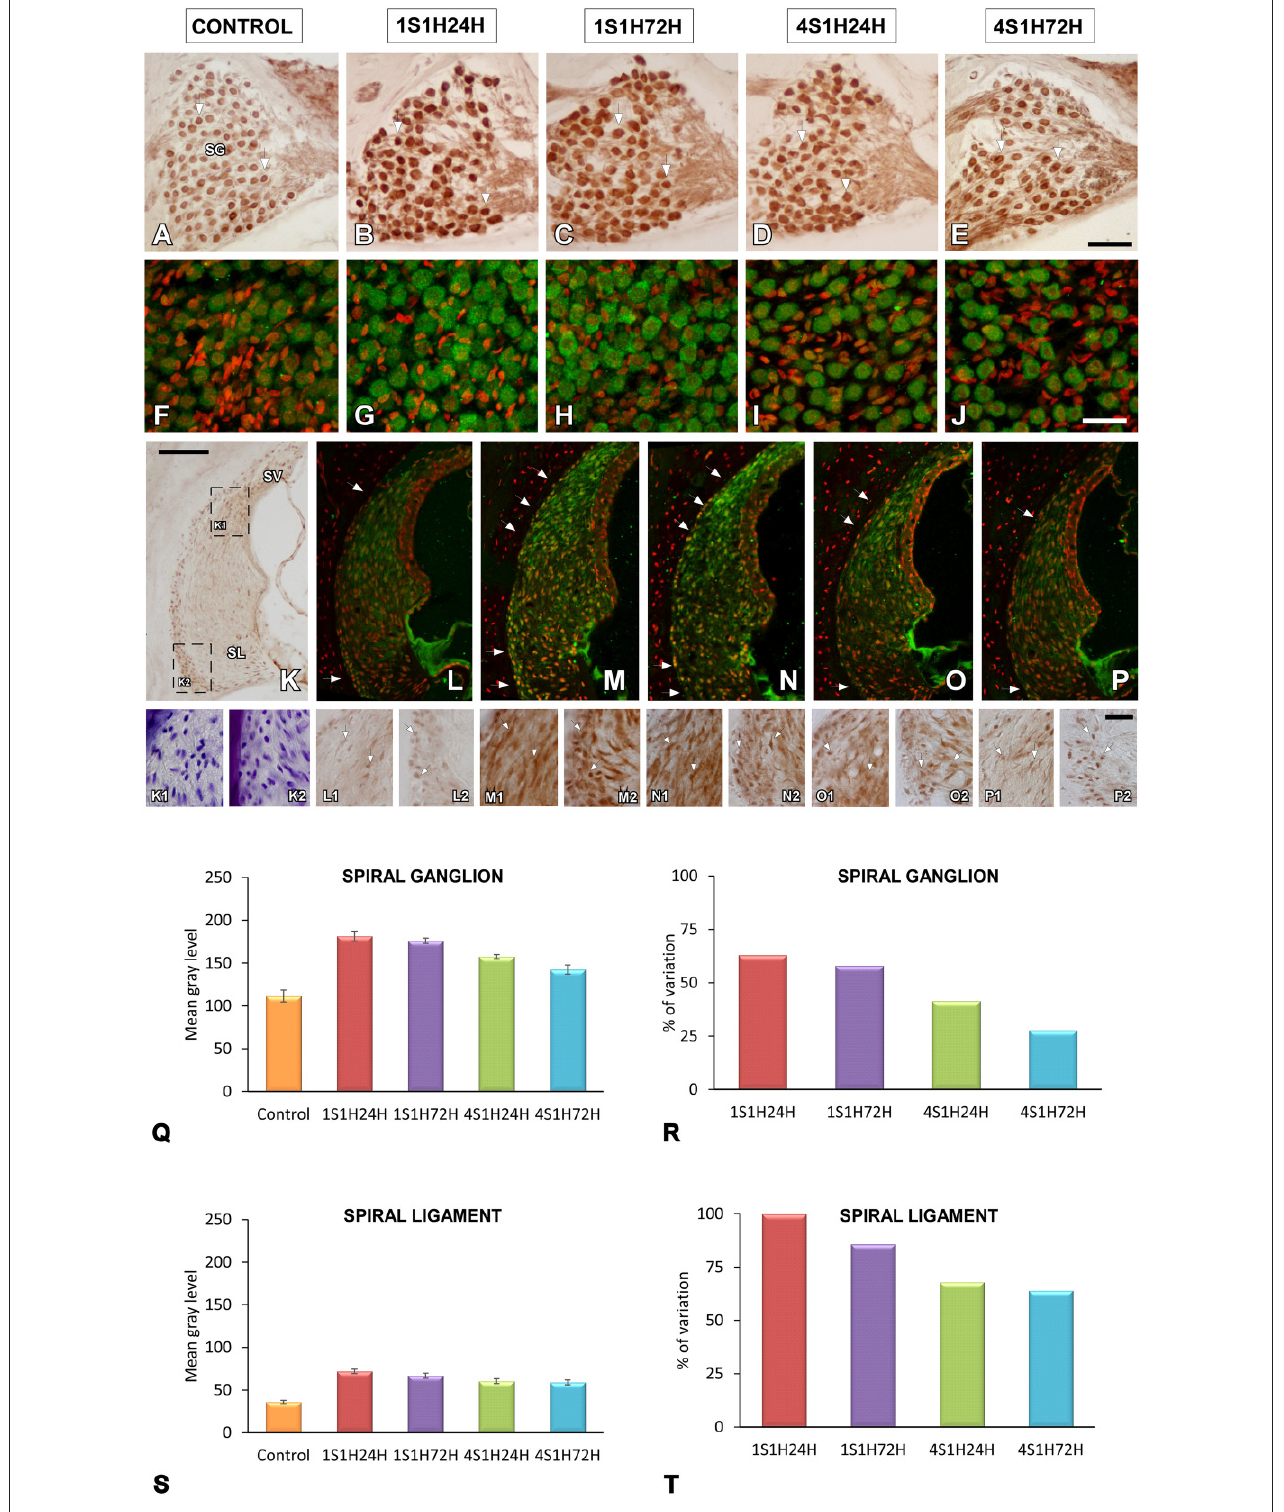
FIGURE 7 | Digitized images illustrating nNOS immunostaining in the spiral ganglion (A–J) and the spiral ligament (K–P) in control and experimental Wistar rats. Before sound conditioning, nNOS immunostaining in spiral ganglion was located within neurons that were lightly immunostained (A,F) , whereas in the